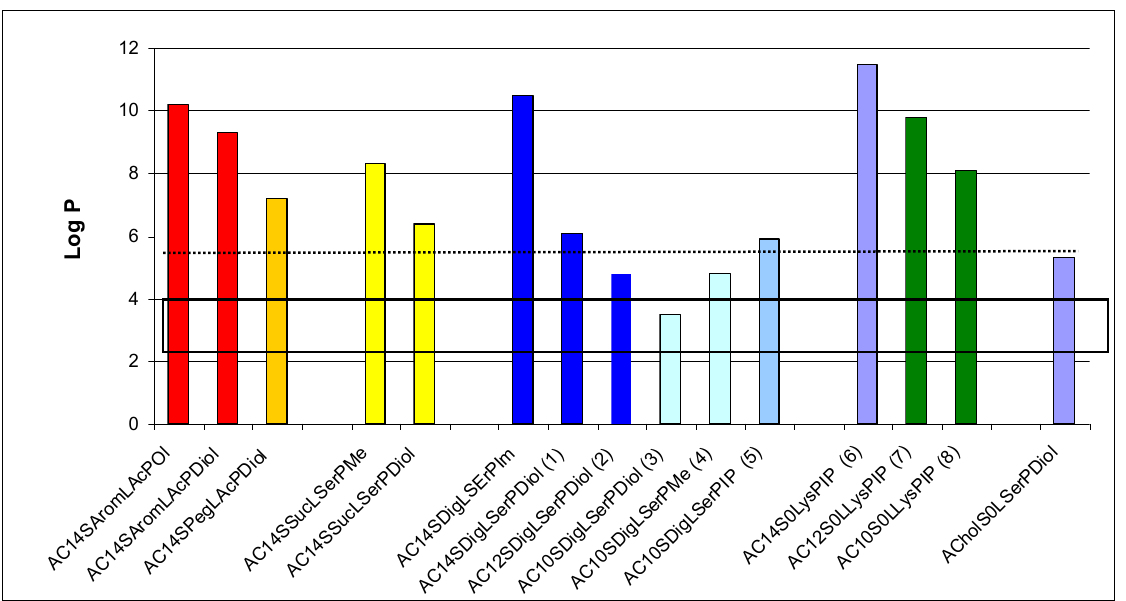
Figure 3. LogP of the different lipothiourea synthesized as calculated with MarvinSketch ® software (ChemAxon, Hungary). LogP between 3.5 and 4.8 (box) were found to be optimised values to formulate thiourea lipids by themselves without addition of energy, just by dilution in water. At a logP below 6.3 (dotted line) the thiourea lipids could still be formulated without addition of a co-lipid. Above 6.3, thiourea lipids required a co-lipid to be suspended in an aqueous medium. The compounds have been named ASLP where A refers to anchor, S spacer, L to linker and P to polar head. As an example, a lipid bearing a 10-carbon chain length, an acetal spacer, a serinol linker and a diol polar head will be named A S L P . A similar lipid which does not bear a Spacer would be C10 Ac Ser diol called A S L P C10 0 Ser diol